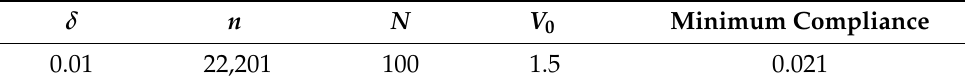
Figure 8: Compliance along the iteration process Figure 9: Approximation of the optimal estate δ